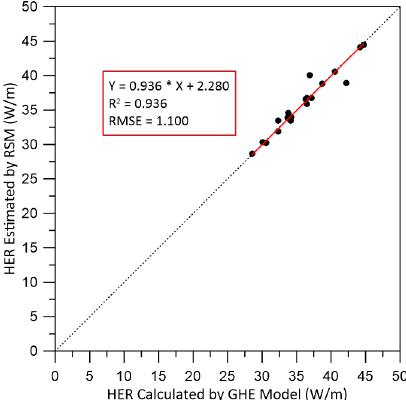
Figure 15. Comparison of the heat exchange rate calculated by GHE models with that estimated by the RSM in the Aizu Basin. HER, GHE, and RSM denote heat exchange rate, ground heat exchanger and response surface methodology, respectively. Energies 2019 , 12 , x FOR PEER REVIEW Table 5. Value of regression coefficients for Equation (2) in the Aizu Basin.